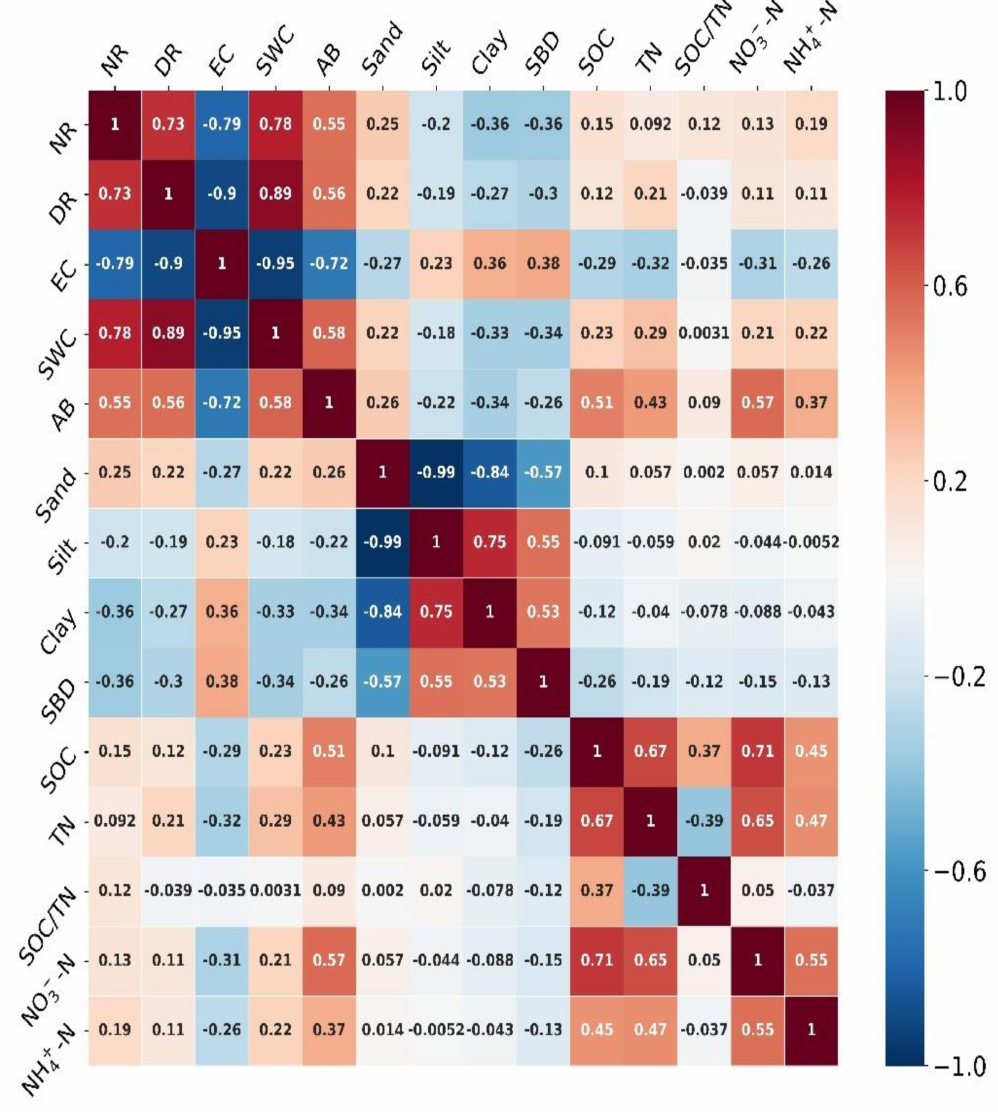
Figure 3. Correlation analysis between soil nitrification rates (NR) and soil denitrification rates (DR) and environmental variables (soil electrical conductivity (EC), soil water content (SWC), aboveground biomass (AB), soil sand content, soil silt content, soil clay content, soil bulk density (SBD), soil organic carbon (SOC), total nitrogen (TN), SOC / TN, nitrate-nitrogen (NO 3 − -N), and ammonium-nitrogen (NH 4 + -N) ) in the studied riparian